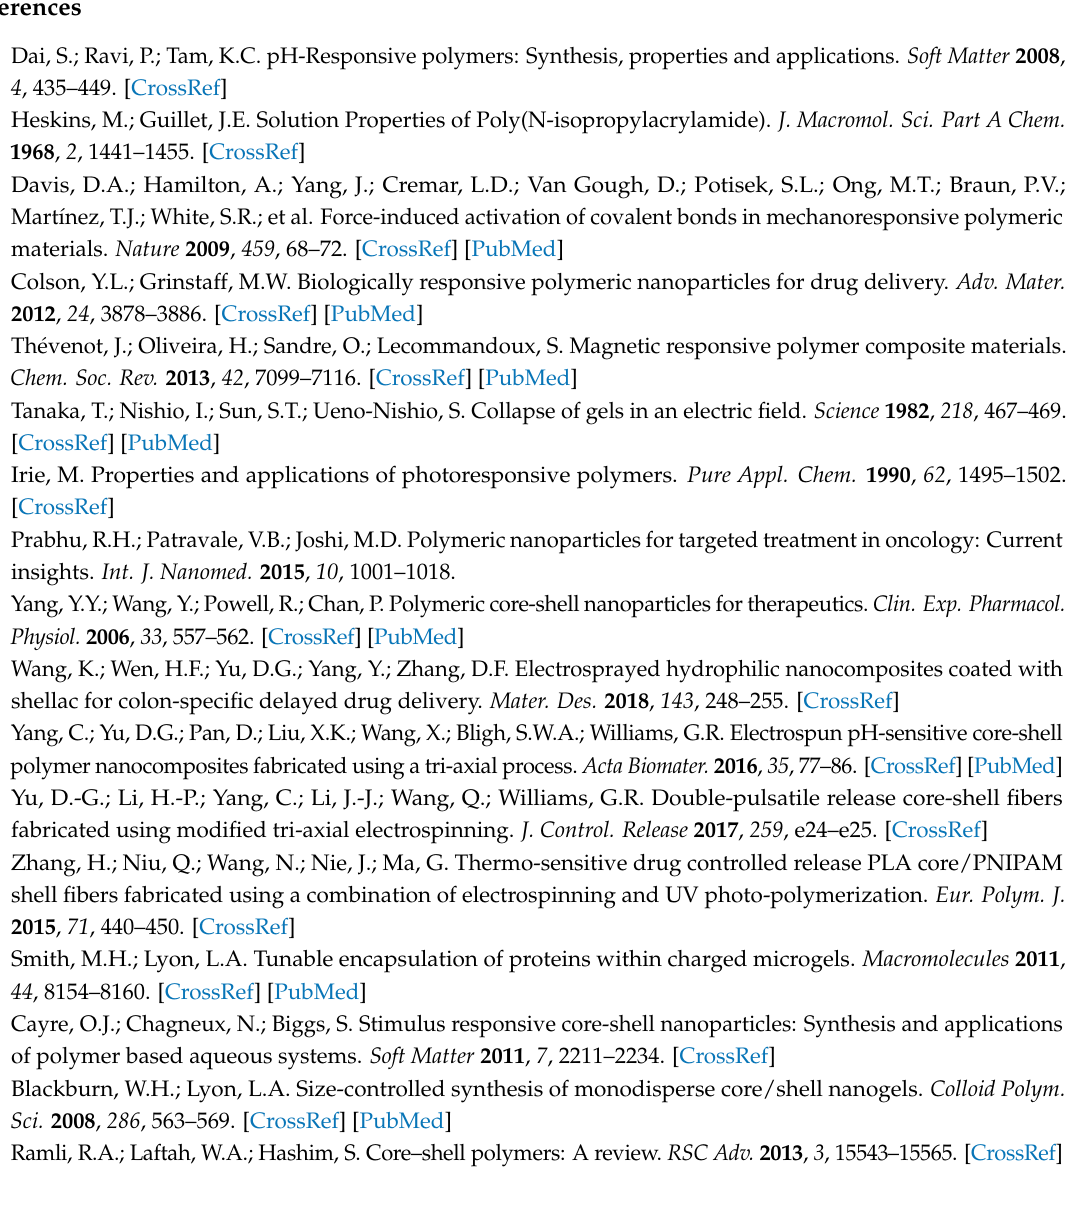
Figure S1: The 1 H NMR of the core and the core-shell nanogels in D 2 O, Figure S2: Scanning electron micrographs of p [NIPAm- co -PEGMA] core particles, Figure S3: Transmission electron micrographs of p [NIPAm- co -PEGMA] core and p [NIPAm- co -PEGMA] (core)/ p [NIPAm- co -AAc] (shell) nanogels with uranyl acetate staining, Figure S4: Determination of VPTT, Figure S5: Potentiometric titration curve of p [NIPAm- co -PEGMA] (core)/ p [NIPAm- co -AAc] (shell) with PEGDMA